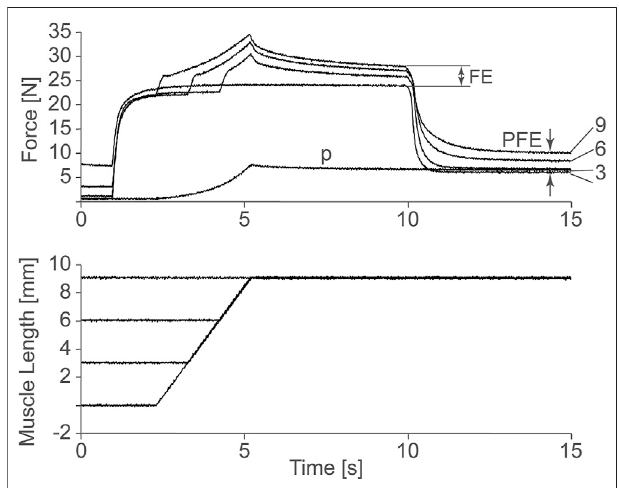
FIGURE 1 | Force as a function of time of a cat soleus muscle stretched 3, 6, and 9 mm, or about 3, 6, and 9% of its total muscle tendon until length. Observe the increase in steady-state isometric force following the active stretches compared to the corresponding purely isometric reference contraction at the fi nal length. This so-called residual force enhancement (FE) increases withincreasingstretchmagnitude. Also notetheincreaseinpassive force following deactivation of the actively stretched muscle compared to the passive force obtained in the passively (P) stretched muscle. This so-called passiveforceenhancement (PFE)alsoincreaseswithincreasingactive stretch magnitudes. Herzog and Leonard, 2002, permission